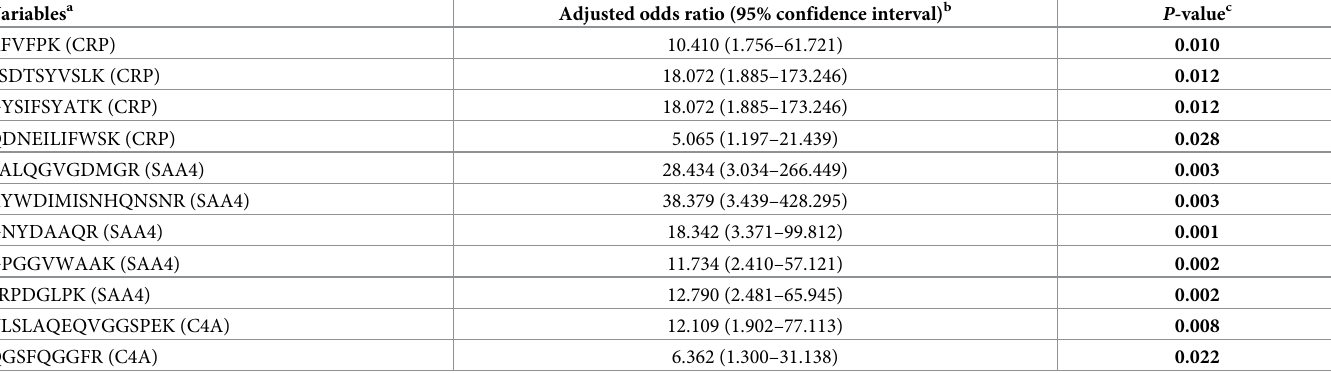
Table 3. Multivariate logistic regression analysis assessing the association between the various maternal plasma proteins and histologic chorioamnionitis in women with preterm premature rupture of membranes included in the MRM verification cohort. Variables a